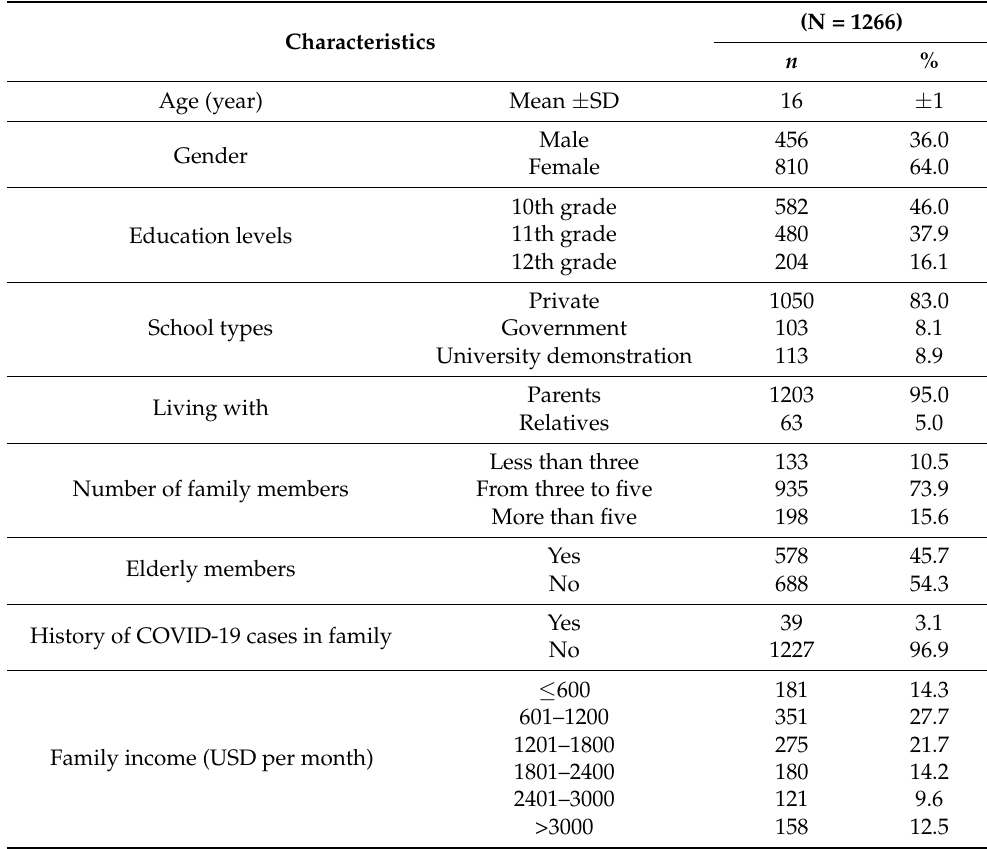
Table 1. Students’ characteristics and